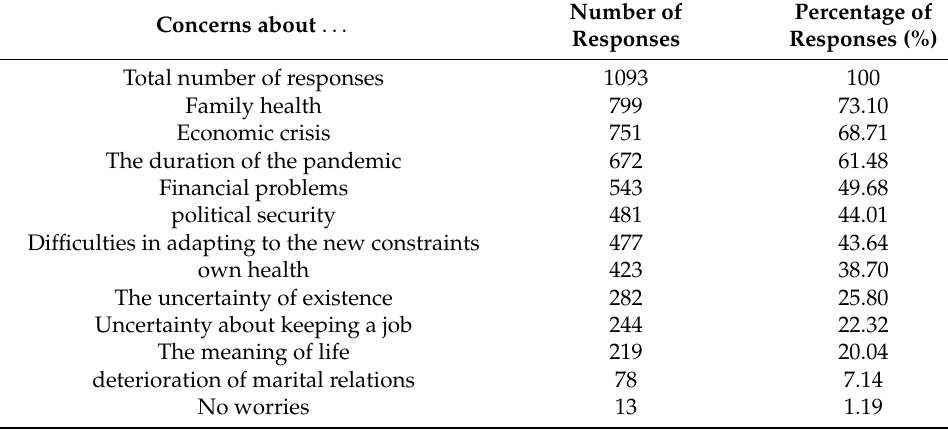
Table 8. Subjective